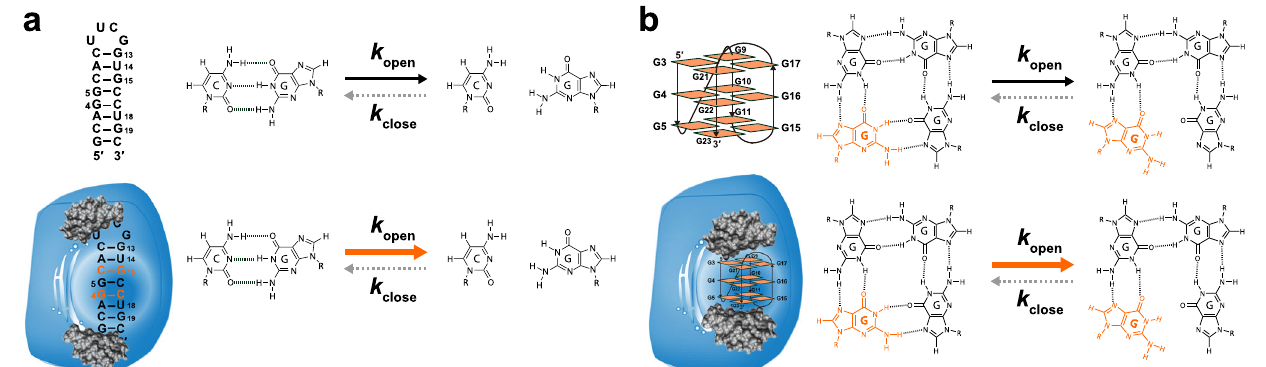
b (teloDNA)AllG-Gbase-pairsopennotsofrequentlyunderinvitroconditions.On theotherhand,alltheG-Gbase-pairsopenmorefrequentlyinlivingcells(indicated by bold orange